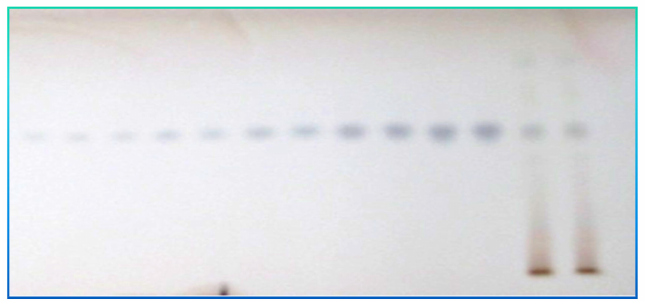
Figure 3. Chromatogram of eupalitin-3- O- β -D -galactopyranoside (R f =